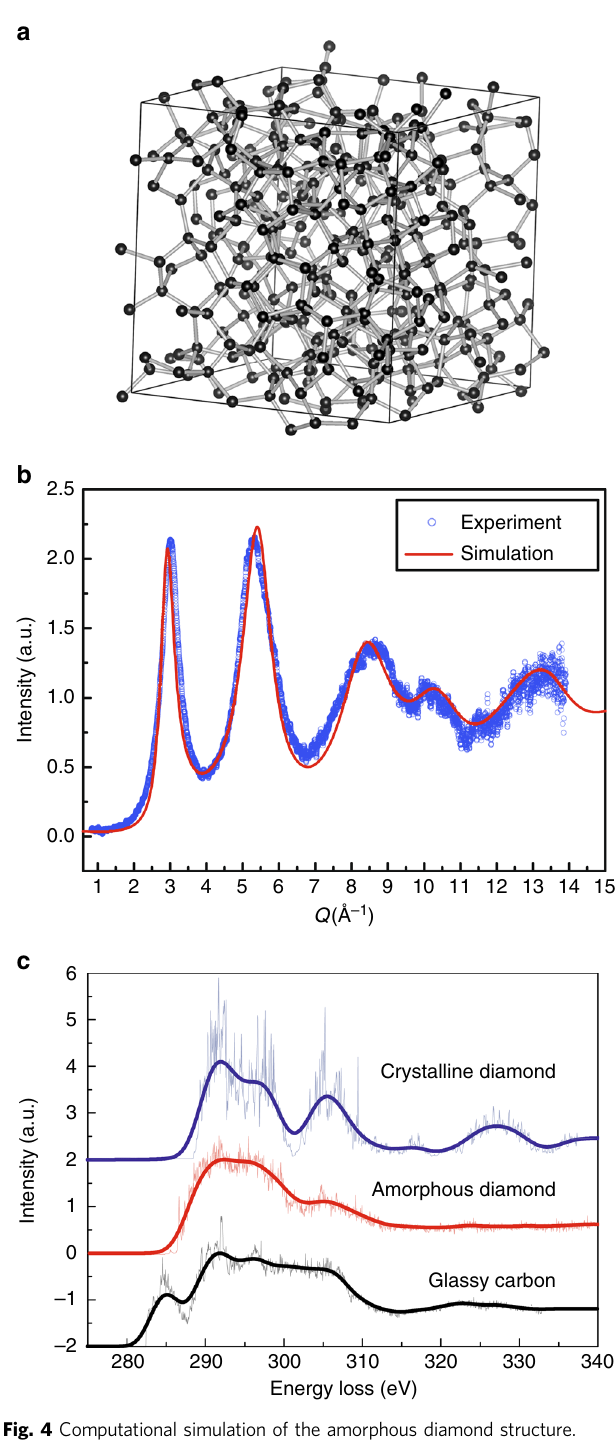
Fig. 4 Computational simulation of the amorphous diamond structure. a Structural model of amorphous diamond. b Calculated XRD pattern (structure factor) of amorphous diamond ( solid red line ) in comparison to experimental data ( open blue circles ). c Calculated EELS for crystalline diamond ( blue ), amorphous diamond ( red ), and glassy carbon ( black ). The as-obtained EELS ( thin lines ) were smoothed using a Gaussian smoothing window function with the window width set as 1.2eV, and the results are shown as thick